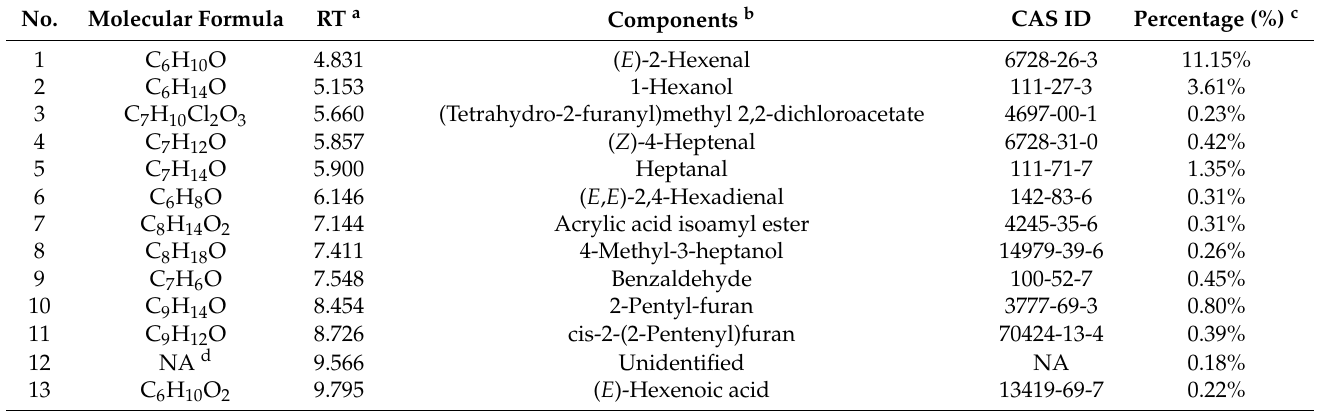
total VOCs. Table 1. The chemical composition of the VOCs distilled from F. hispida Table 1. The chemical composition of the VOCs distilled from F. hispida .